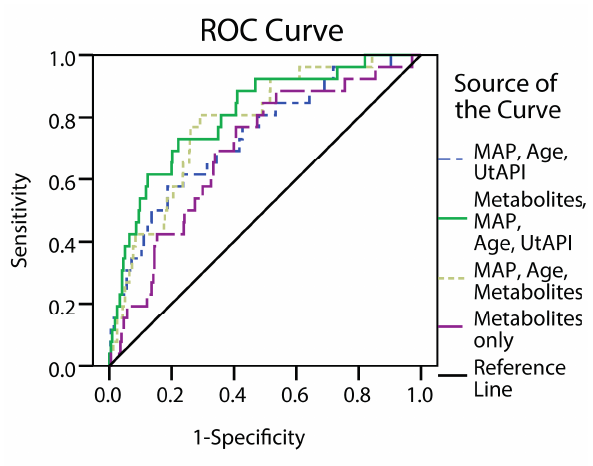
Figure 4. Receiver Operator Characteristic (ROC) curve comparison from logistic regression analyses. Prediction of preeclampsia using logistic regression, with risk of preeclampsia as dependent variable and maternal age and MAP in combination with urinary metabolites (Hippurate and Creatinine) or UtAPI as independent variables. Abbreviations: MAP, Mean Arterial Pressure; UtAPI, Uterine Artery pulsatility